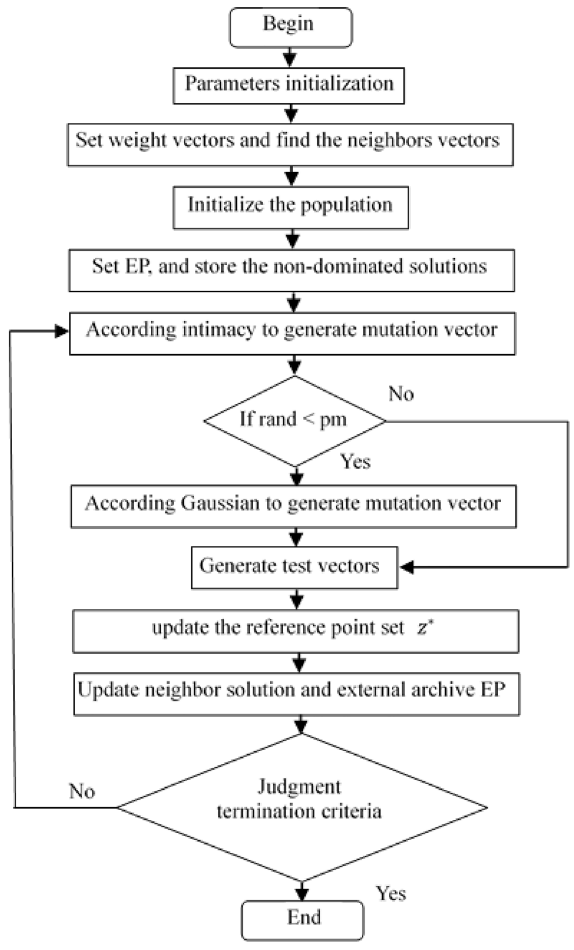
Figure 1. Flow chart of the MOEA/D/DEM